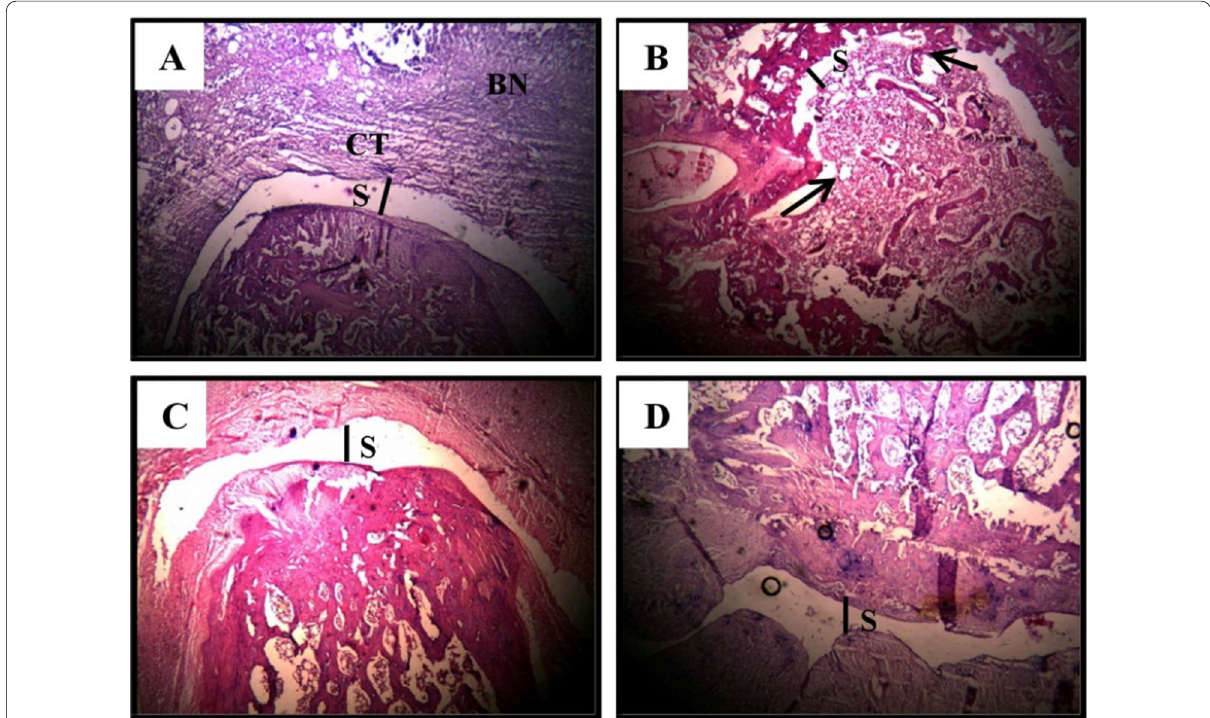
Fig. 4 Histological sections (40 ) of tarsotibial joints of left hind paw form different animal groups. A Control group showed normal synovial space × (S), articular cartilage (CT), bone structure (BN) and absence of inflammatory cells; B CFA-induced arthritic group showed marked infiltration of inflammatory cells, synovial hyperplasia and marked reduction in synovial joint (shown by arrow); C prednisolone-treated group and D dry latex of C. procera-treated group showed less inflammatory cell infiltration, minimal synovial hyperplasia and modest reduction in joint